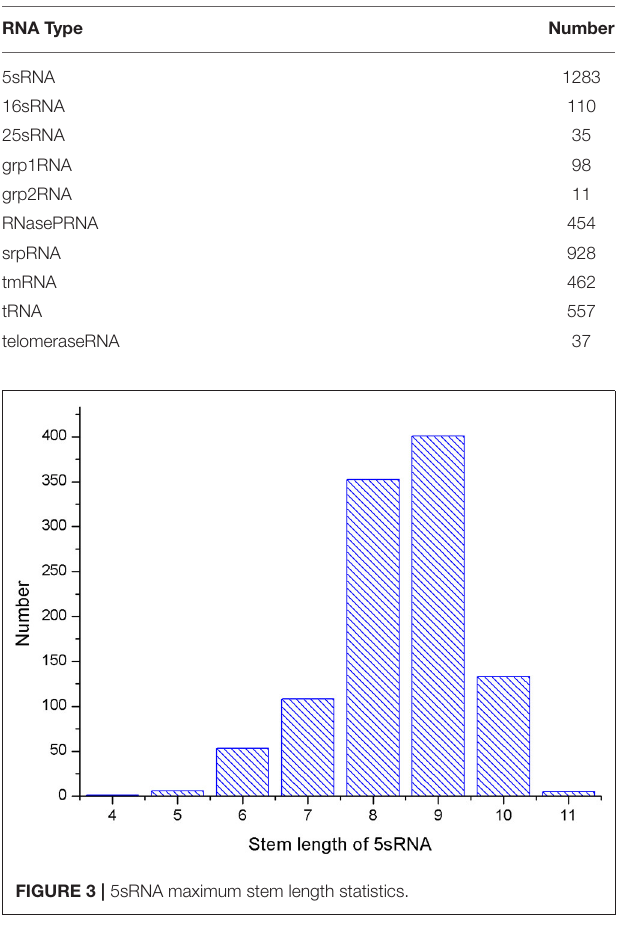
TABLE 1 | Distribution of RNA types and their number in each dataset.